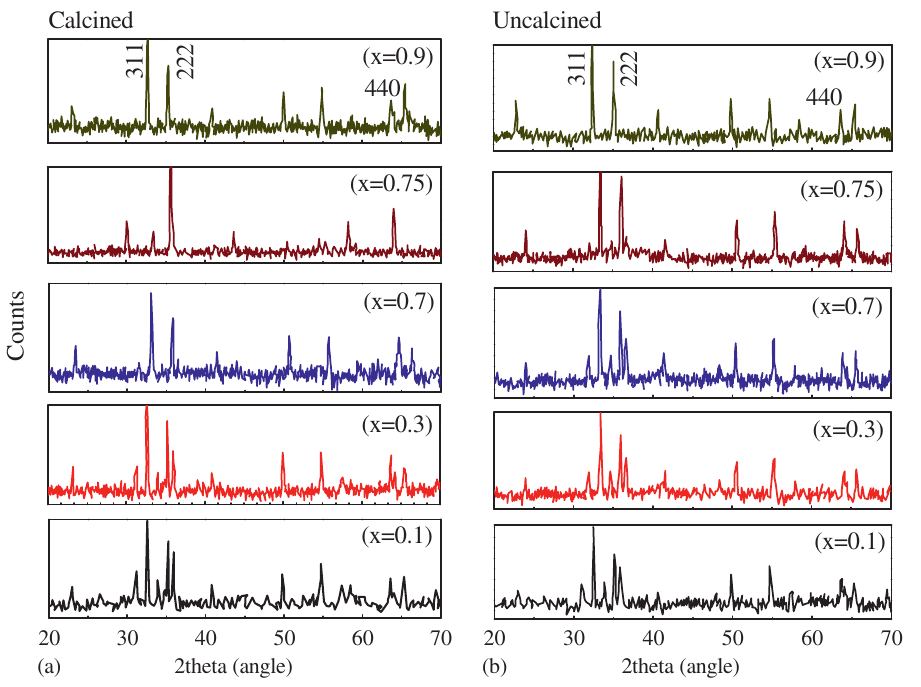
Figure 3: XRD patterns of cal- cined and uncalcined samples of Mg x Zn 1-x Fe 2 O 4 ferrite.